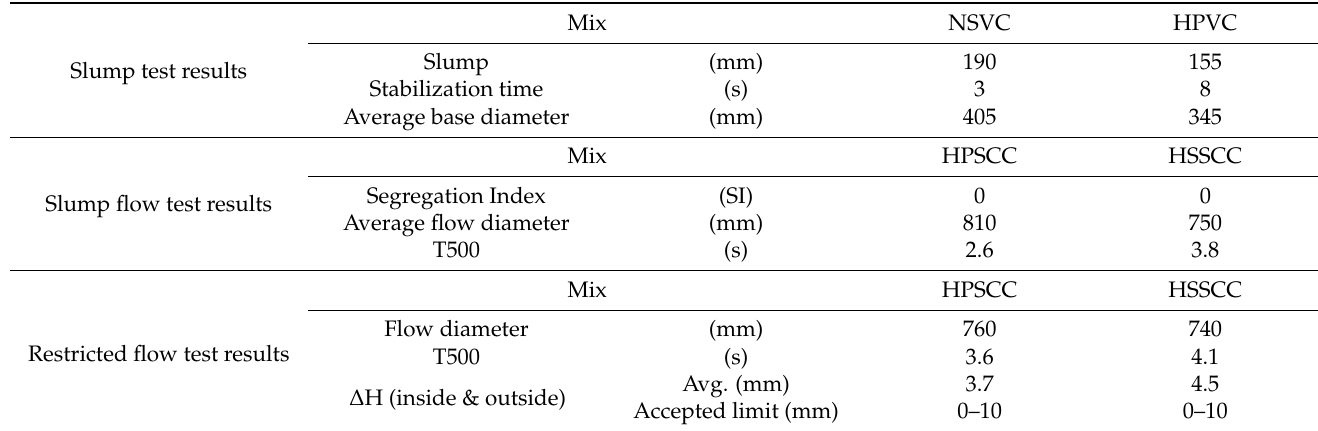
Table 4. Slump test result of normal strength-vibrated concrete (NSVC) and high-performance highly-viscous concrete (HPVC) mixes, a flow test result of high-performance self-consolidating concrete (HPSCC) and high-strength self-compacted concrete (HSSCC), and restricted flow test result for HPSCC and